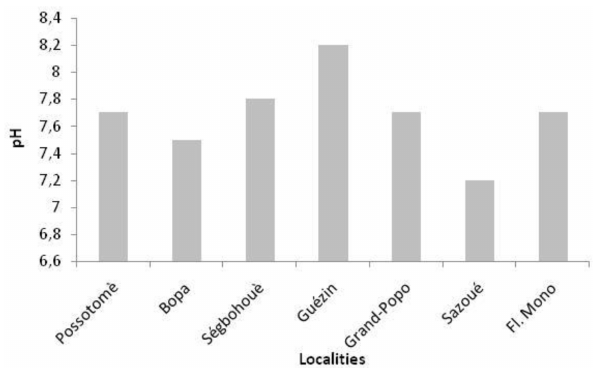
Figure 6. Spatial variation of pH measured in Ahémé lake in Octo- ber 2000 (Source: PAZH, 2002).